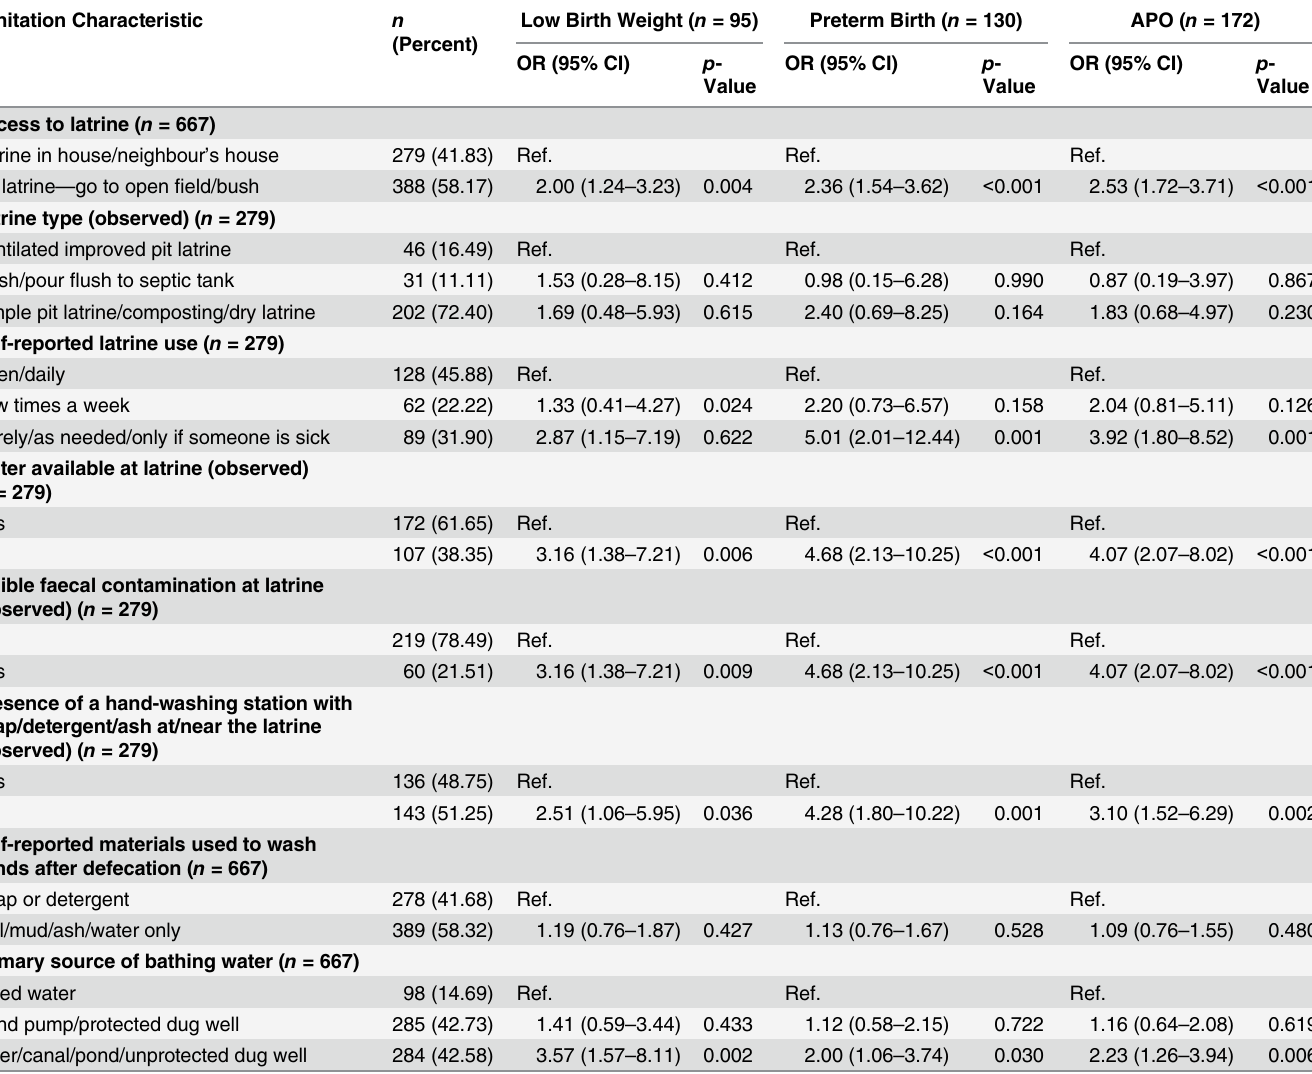
Table 2. Pregnant women ’ s sanitation access and use with unadjusted odds ratios for adverse pregnancy